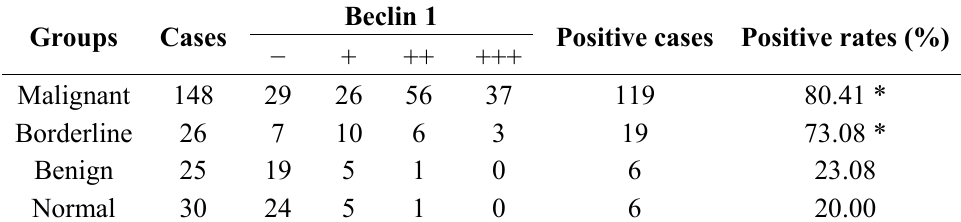
Table 1. Expression of Beclin 1 in different ovarian